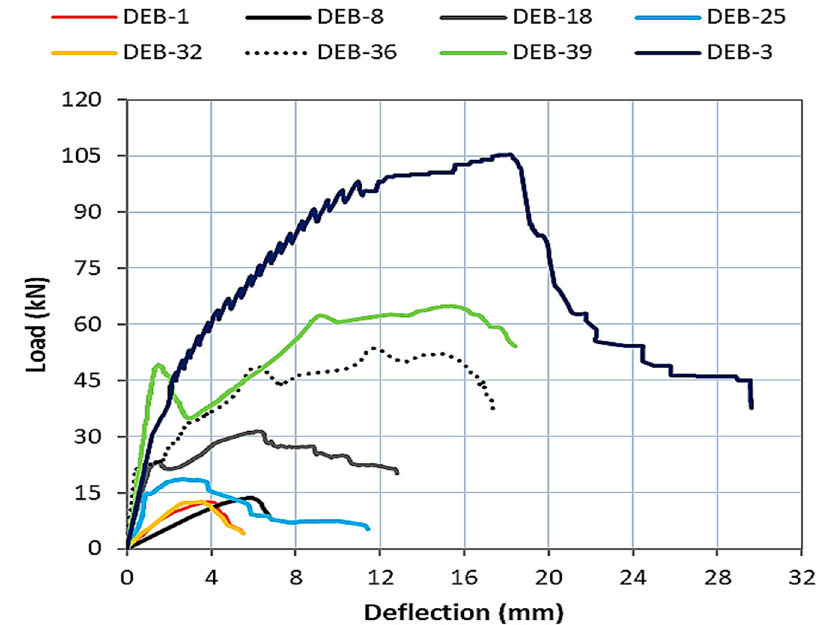
Figure 7. Load-deflection relationship of DEBs.